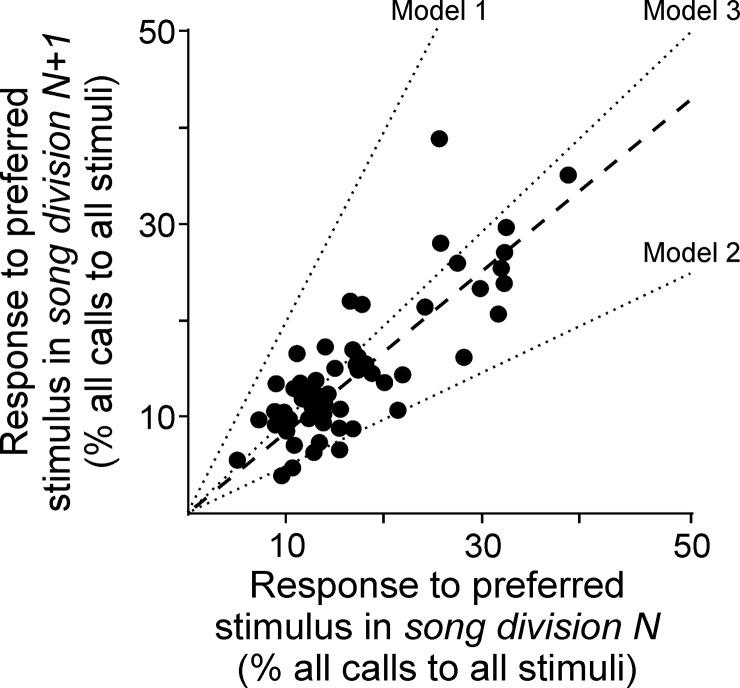
Behavioral indications of mate preference were consistent with female preference for some feature that is conserved throughout song performance.In our comparisons to investigate the relation between our dataset and predictions from each of three models (dotted lines, models detailed in the Methods), linear regression revealed a slope of 0.81 (dashed line, n = 12 birds), which was significantly different than zero (p < 0.001), and a y-intercept of 0.02 that was not significantly different than zero (p = 0.25). Each data point represents a test of song preference performed with an individual female (n = 5.25 ± 1.52 trials per female; for each natural song that was used to create experimental stimuli, each trial represents a division of that natural song at the level of halves, quarters, eighths, etc. as detailed in the Methods). The slope of our dataset (0.81) was significantly different than 2 (paired t-test, t = -7.69, df = 110, p < 0.001) and significantly different than ½ (paired t-test, t = 5.72, df = 110, p < 0.001) but not different than 1 (paired t-test, t = 0–1.10, df = 110, p = 0.27). Therefore, our data are most consistent with the Model 3, indicating that female song preference may be closely related to some feature that largely conserved throughout the song performance.